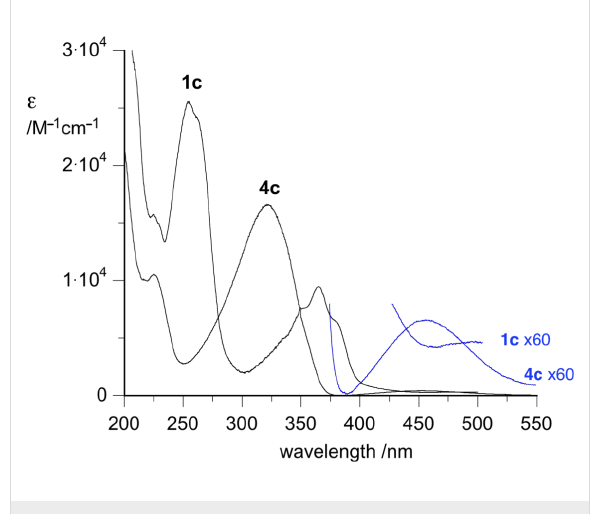
Figure 3: Electronic absorption spectra for 1c and 4c (MeCN). Blue lines represent magnified areas of the